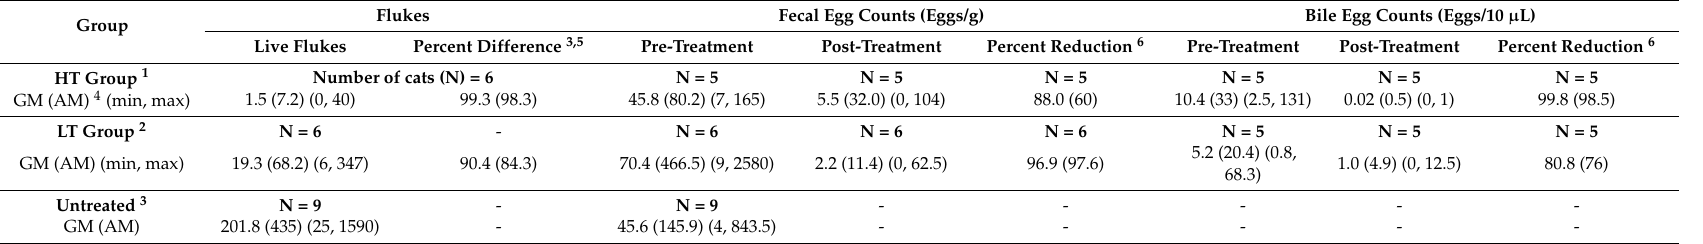
Table 2. Pre- and post-treatment fecal and bile egg counts (FEC; BEC) and calculated